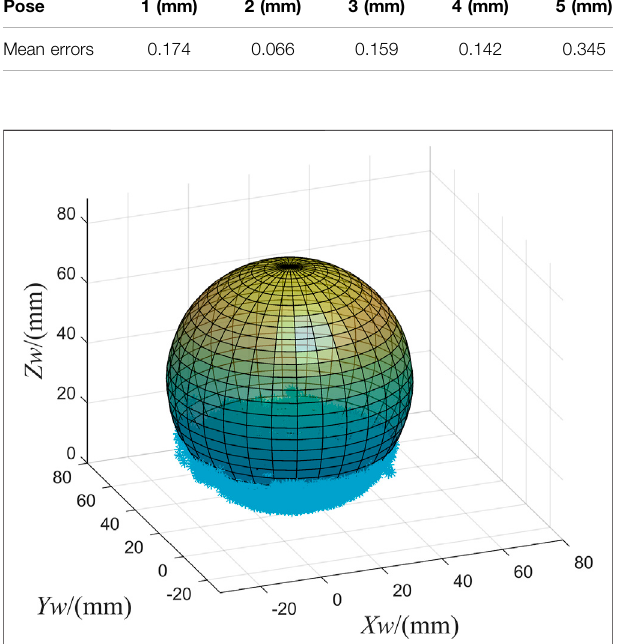
FIGURE 11 | Sphere reconstruction